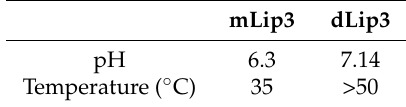
Figure 4. Response surfaces and contour plots generated using experimental design data. ( a ) Residual activity of mLip3 after pH and T treatment for 30 min; ( b ) Residual activity of dLip3 after pH and T treatment for 1 h. Table 5. Optima pH and temperature values for mLip3 and dLip3